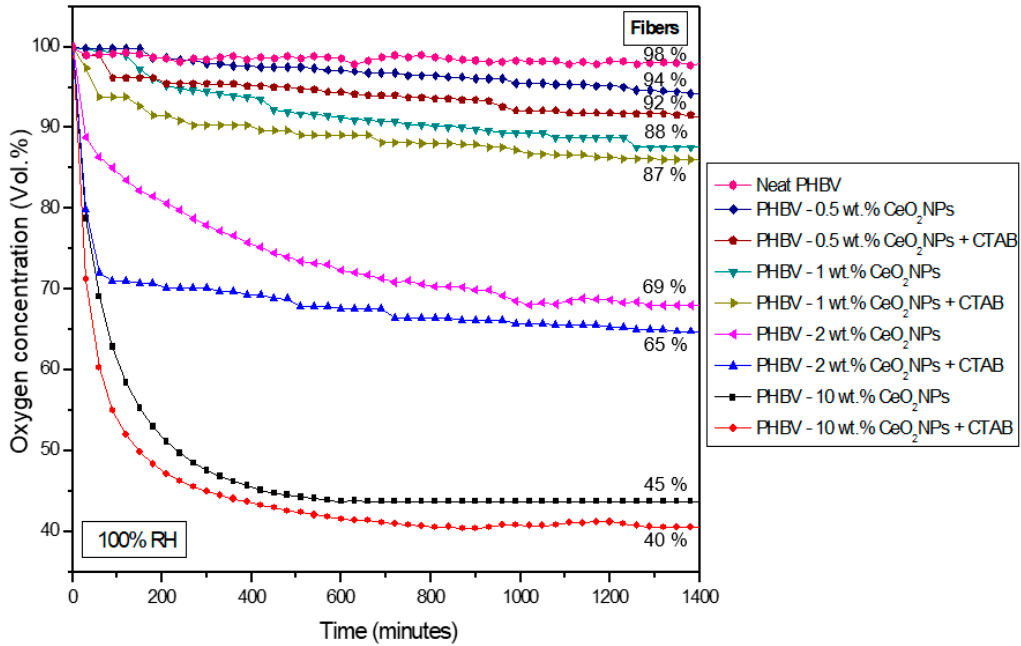
Figure 12. Headspace oxygen volume depletion of electrospun poly(3-hydroxybutyrate-co-3-hydroxyvalerate) (PHBV) fibers loaded with 0.5 wt.%, 1.0 wt.%, 2.0 wt.%, and 10.0 wt.% cerium oxide nanoparticles (CeO 2 NPs) with and without hexadecyltrimethylammonium bromide (CTAB). The samples were tested at 100% relative humidity (RH).